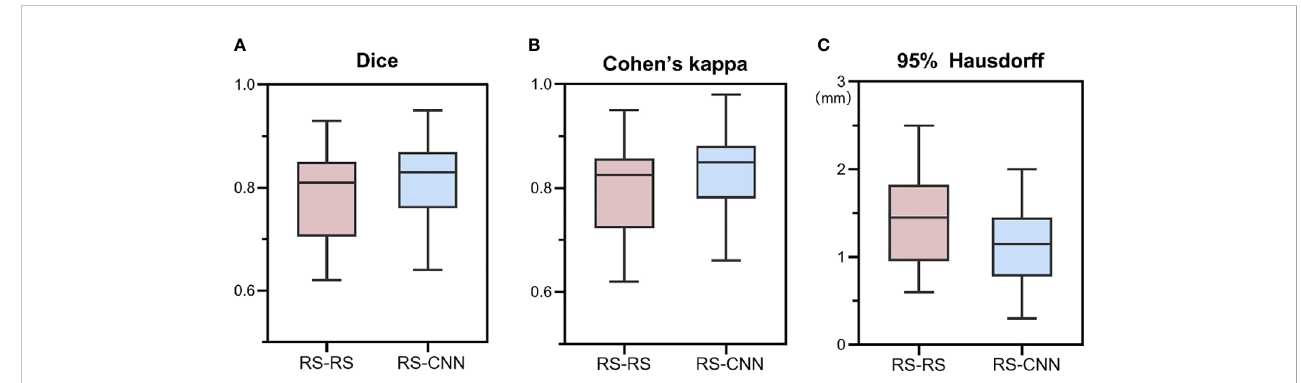
FIGURE 6 Box-plot diagrams of Dice (A) , Cohen ’ s kappa (B) , and 95% Hausdorff metrics (C) compared between the radiologists ’ segmentation (RS-RS) and between the experts and deep learning model segmentation (RS-CNN). RS, radiologists; CNN, convolutional neural